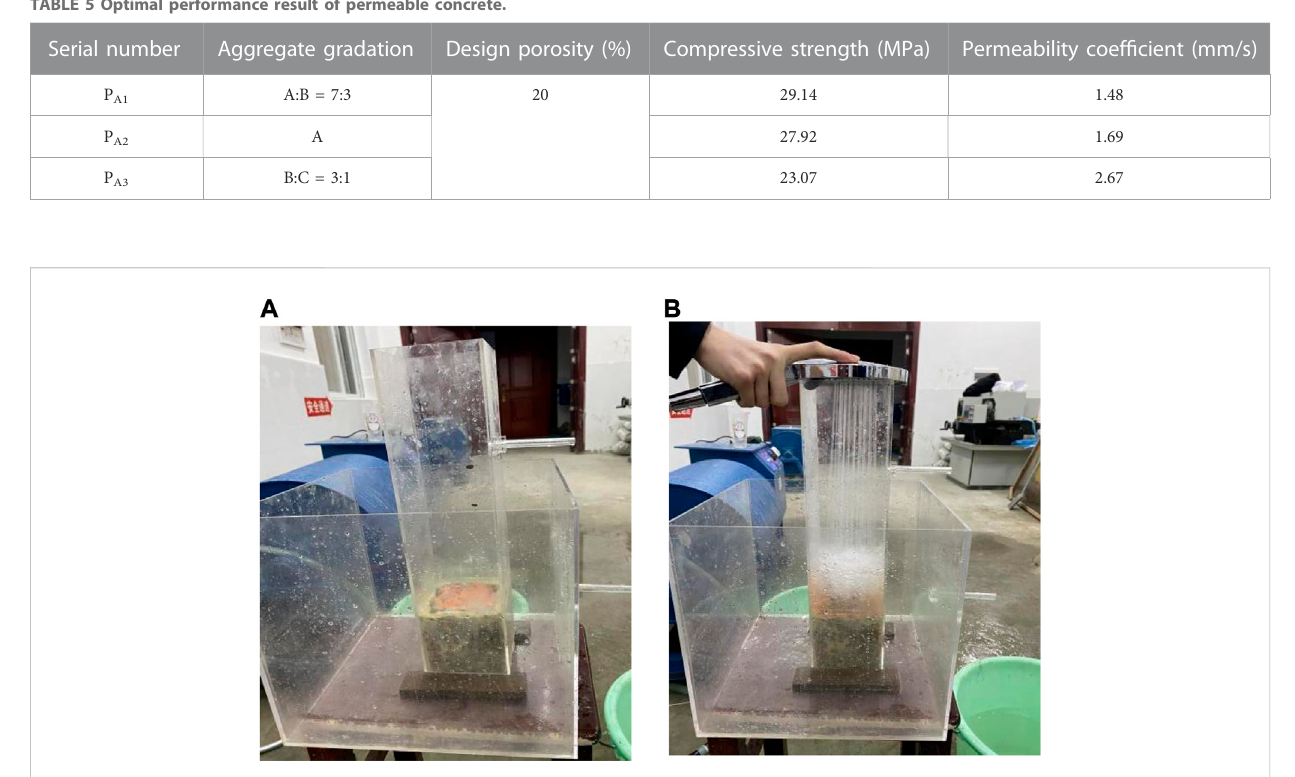
FIGURE 4 Laboratory clogging test: (A) pervious clogging devices; (B) simulated